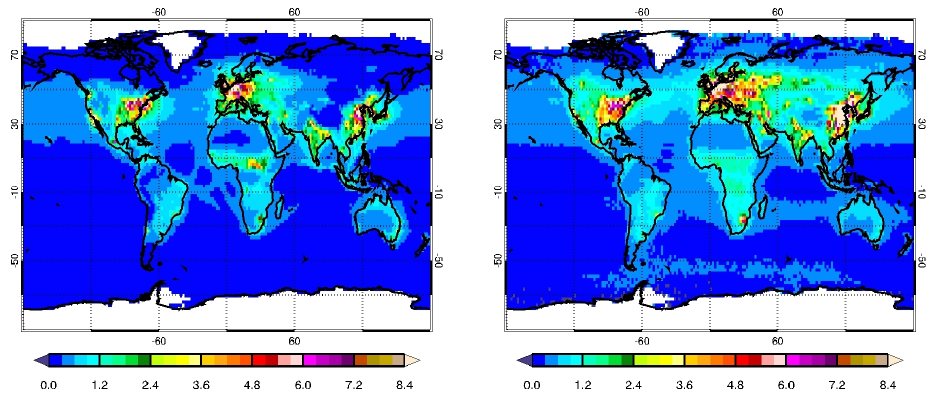
Figure 15. Long-term average of daily tropospheric NO 2 VCD [10 15 moleccm − 2 ] from September 2009 to March 2012 for (left) MACC_osuite simulations and (right) SCIAMACHY satellite observations. Blue colours represent relatively low values; red/brown colours represent relatively high values. Table 7. Statistics derived from satellite observations (SCIAMACHY from September 2009 until March 2012, GOME-2 from April 2012 to December 2012) and the MACC_osuite simulations of daily tropospheric NO 2 VCD [10 15 molec cm − 2 ] averaged over different regions for September 2009 to December 2012. Region United States Europe South Asia East Asia Southern Africa North